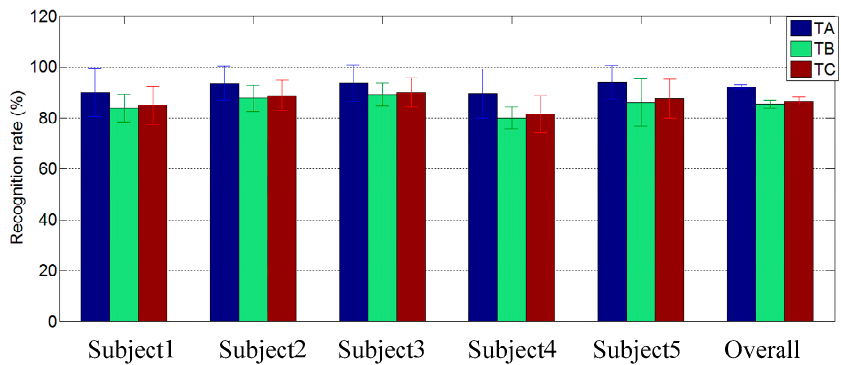
Figure 9. The recognition results under three different testing sets (Sub3 as the reference subject).